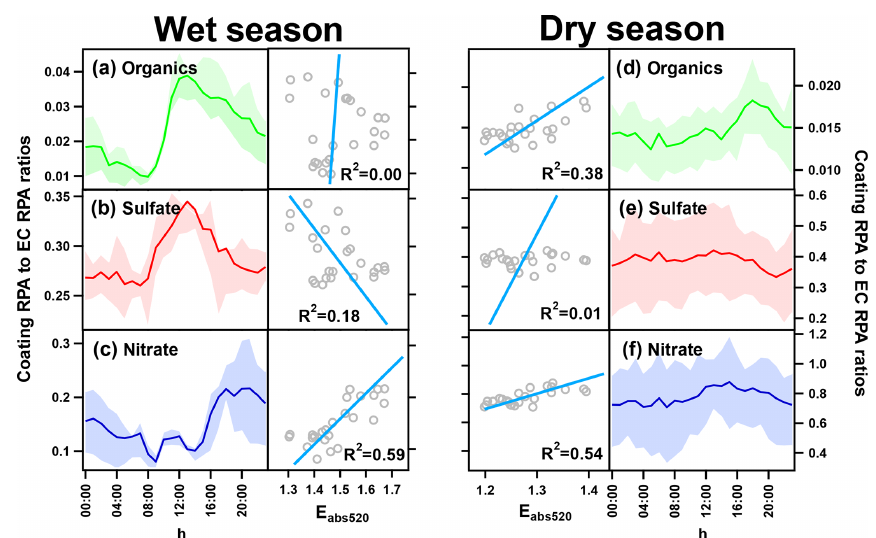
Figure 7. Diurnal variations in coating (including organics, sulfate and nitrate) RPA to EC RPA ratios of EC-aged particles measured by SPAMS in the wet and dry seasons. The solid lines represent hourly averages and the shaded areas represent 25th and 75th percentiles. (a–c) In the wet season, organics, nitrate and sulfate RPA to EC RPA ratios. The scatter plots show the corresponding correlations with E abs520 . The scatter plots share the same y -axis scale with the diurnal plots. Panels (d) – (f) are the same as (a) – (c) but for the dry season. The following ions are used: EC ( m/z + 12 [ C ] + , + 24 [ C 2 ] + , + 36 [ C 3 ] + , + 48 [ C 4 ] + ), organics ( m/z + 43 [ C 2 H 3 O ] + ), sulfate ( m/z − 97 [ HSO 4 ] − , − 80 [ SO ] − ) and nitrate ( m/z − 62 [ NO ] − , − 46 [ NO ] − 3 3 2